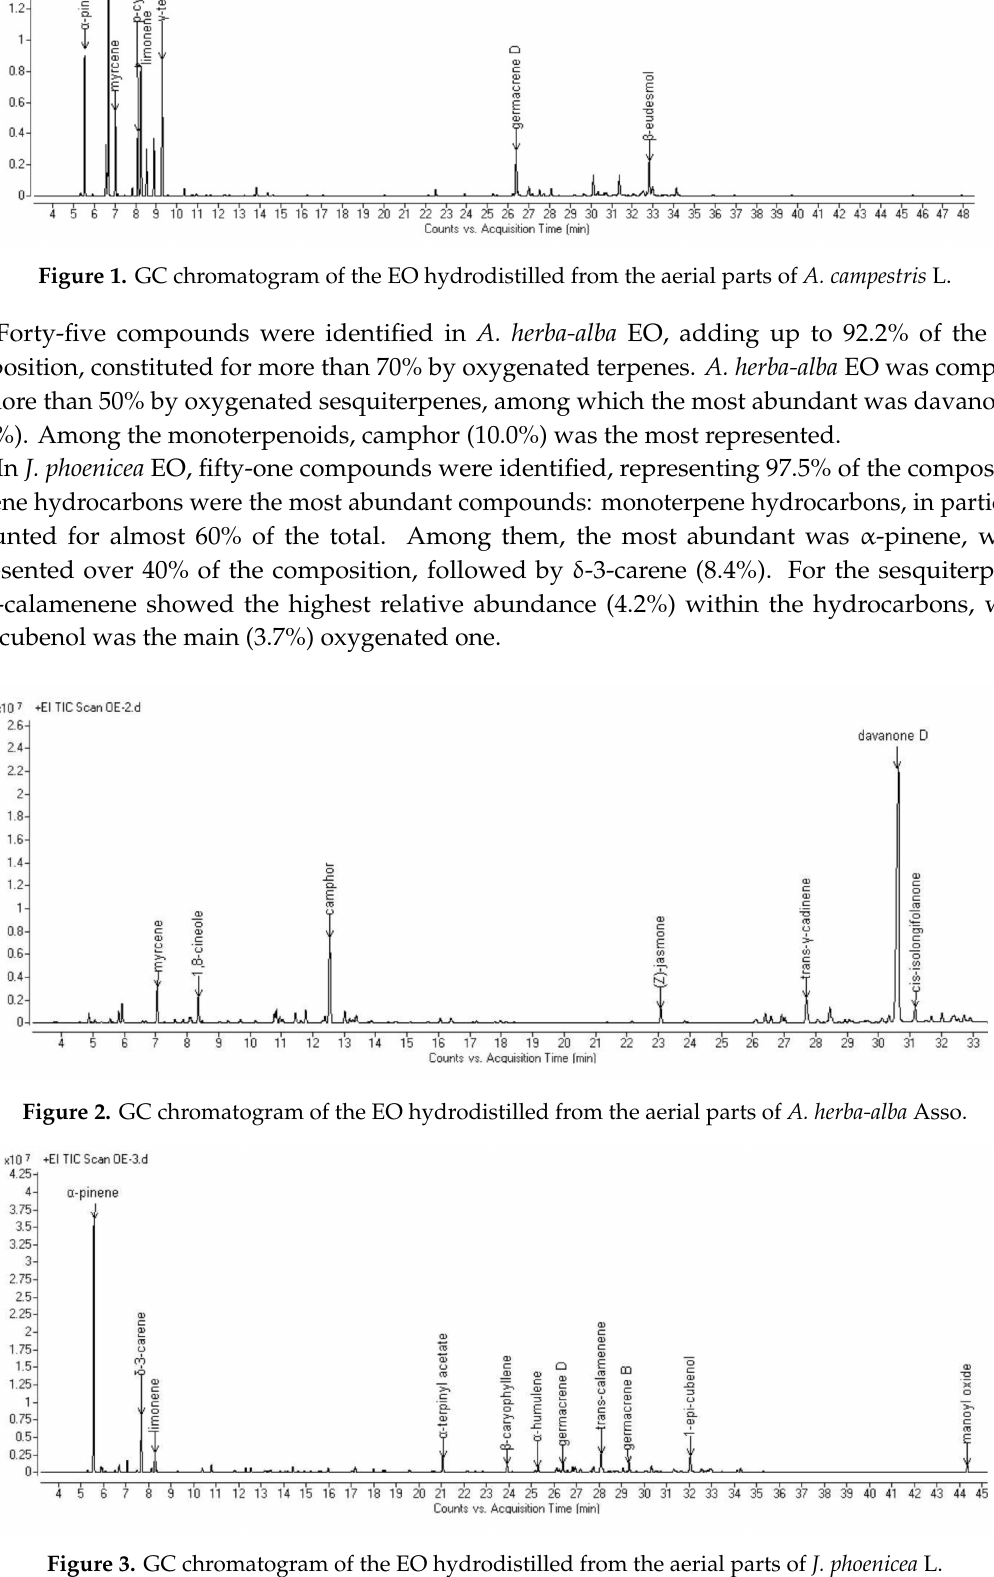
Figure 3. GC chromatogram of the EO hydrodistilled from the aerial parts of J. phoenicea